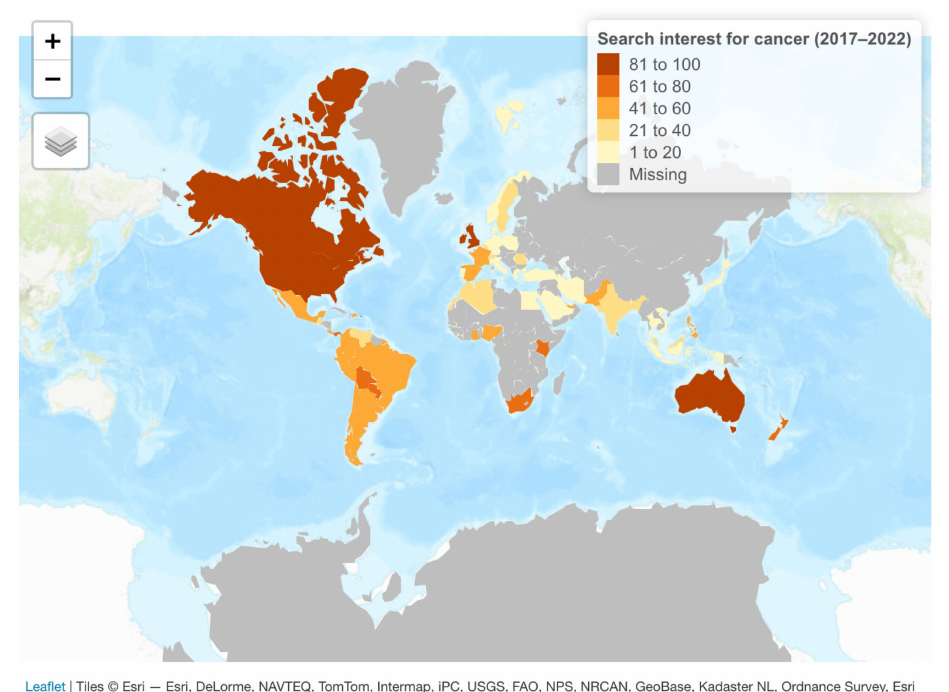
Figure 2. Internet search interest for “cancer” at the world level: (April 2017–March 2022). Source of data: Google Trends. Map is based on estimation results and uses the packages “gtrendsR” [19] and “tmap” [21] in R